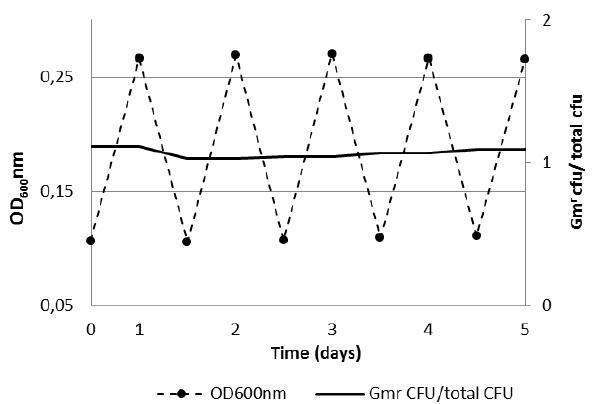
Figure 4. Optical density measurements indication stabil- ity of the Gm r marker in the mutant strain, in the absence of selection, after several generations during 5 d of serial batch